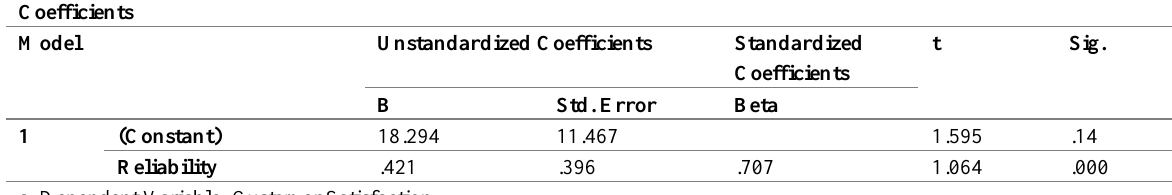
Table 9: Hypothesis Test Results on The Relationship Between Reliability and Customer Satisfaction